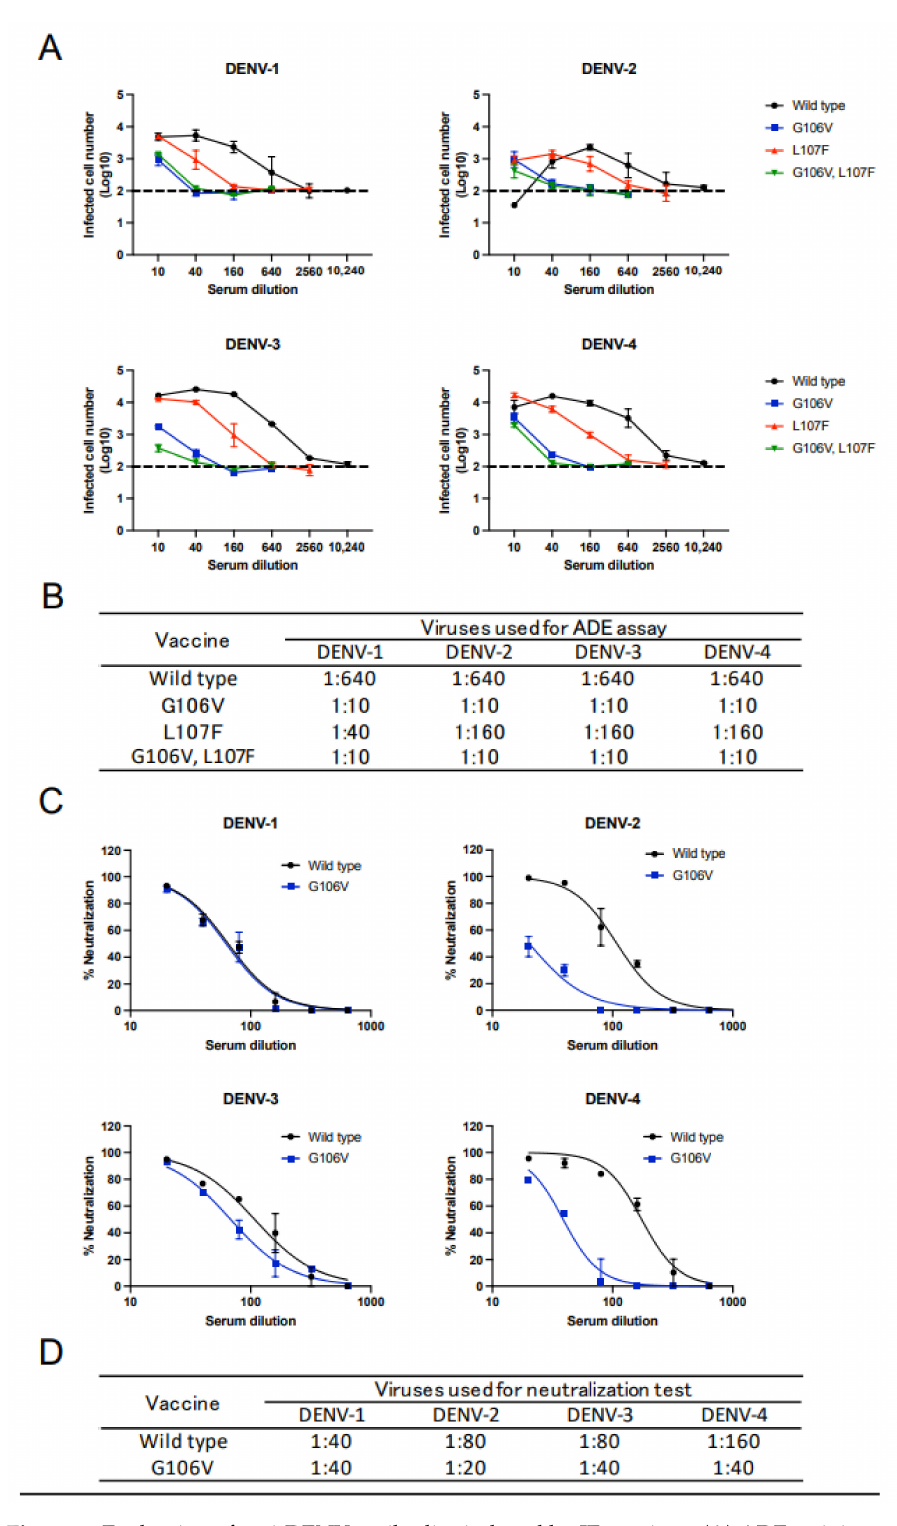
Figure 3. Evaluation of anti-DENV antibodies induced by JE vaccines. ( A ) ADE activity against four serotypes of DENV. Dotted lines indicate the baseline of infected cells in control (100 infected cells; log 10 2.0). Complement was not added to this assay. ( B ) ADE titer. The ADE titer is a maximum serum dilution factor exceeding the ADE threshold (log 10 2.5). ( C ) Neutralizing activity against four serotypes of DENV. ( D ) NT 50 values against DENV. NT 50 is calculated as a maximum serum dilution yielding >50%